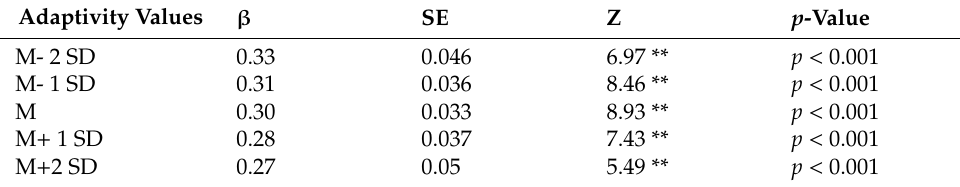
Table 4. Conditional effects at adaptivity (mean and ±2 SD) on PU->EC-> Stickiness. Adaptivity